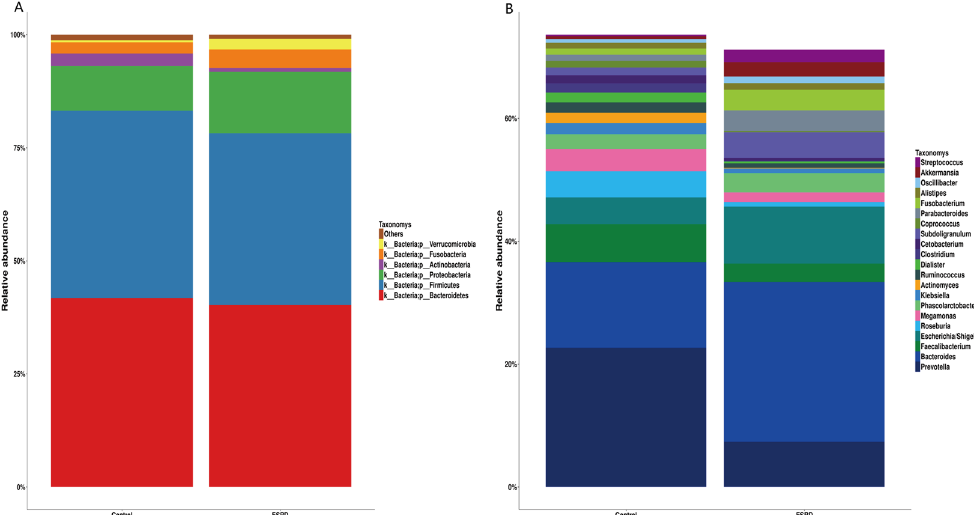
Figure 2. Relative abundance of the gut microbiota in this study. Microbiome composition in human from controls (n = 26) or patients with ESRD (n = 27). The composition is based on 16S rRNA sequecing. Results are shown at the ( A ) phylum and ( B ) genus level. The figure shows species median relative abundance >= 1% of total abundance in either the healthy control group or the ESRD group, and value < 1%, unclassified, unidentified are classified as Others.